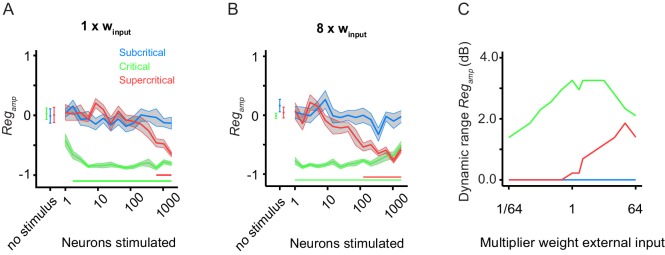
Critical networks exhibit robust pre-stimulus amplitude regulation for a wide range of input stimulus strengths.(A) Replicates Figure 2G for comparison purposes. (B) The dynamic range of pre-stimulus amplitude regulation changes if we increase the input weight by a factor of 8. (C) Subsequently, we ran 10 network initializations for each of the three example networks (sub-critical, critical, super-critical), at different levels of external input weight, ranging from 1/64 to 64 times the baseline value (winput = 0.0085). The dynamic range of pre-stimulus amplitude regulation was calculated as the orders of magnitude over which it shows significant effects. In critical networks, pre-stimulus amplitude regulation occurs over a wider range of stimulus sizes than sub/supercritical networks, regardless of the input weight.